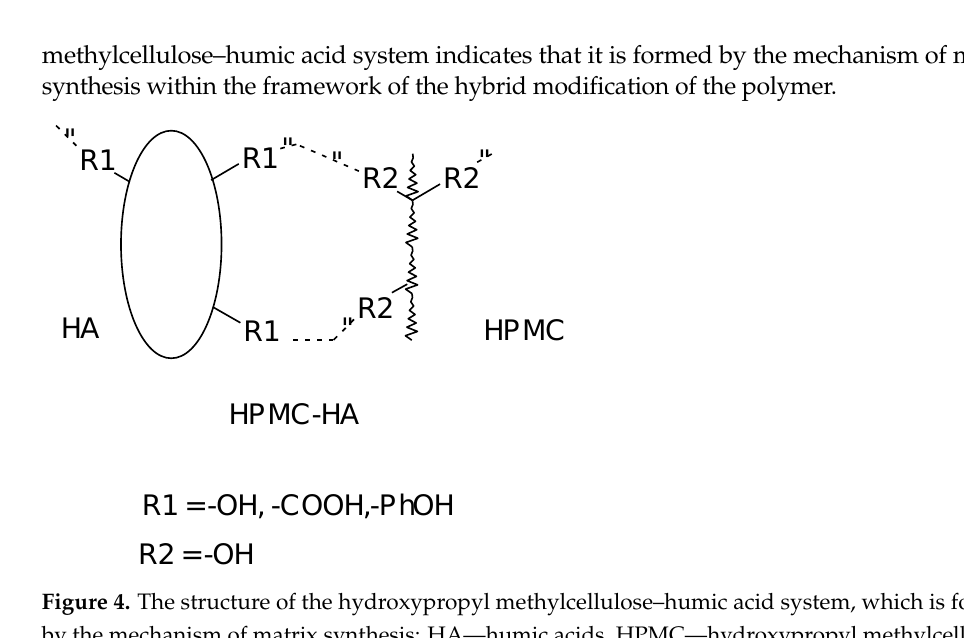
Figure 4. The structure of the hydroxypropyl methylcellulose – humic acid system, which is formed